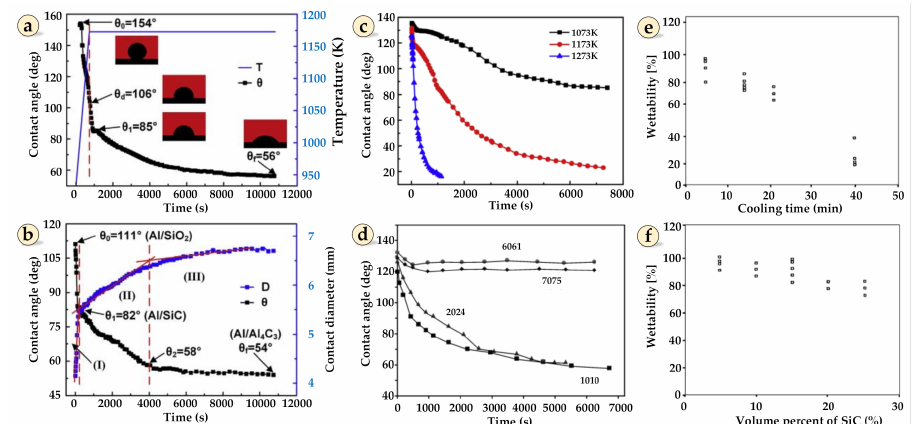
Figure 4. Variation of contact angle of Al-SiC system with time during ( a ) conventional sessile test [30], ( b ) isothermal dwelling at 1173 K by a dispensed sessile experiment. Herein, D represents the drop diameter [30]. ( c ) the variation of contact angle against time at different temperatures for Al- 3.0 wt.% Ti alloy on SiC substrate [30]. ( d ) the variation of contact angle versus time in Al-TiC system at 900 ◦ C [36]. ( e , f ) the effect of solidification time of SiC reinforced aluminum matrix composite on wettability